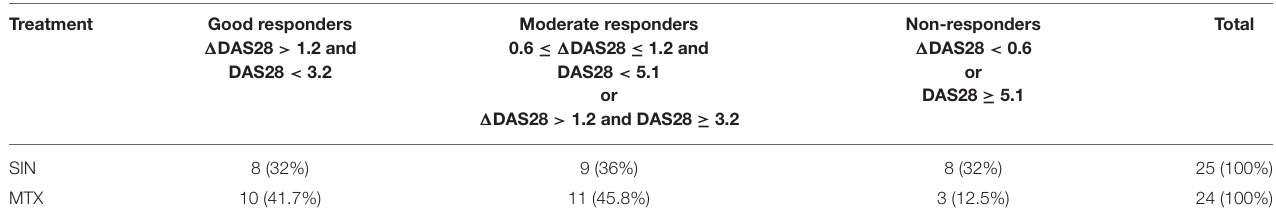
TABLE 3 | Numbers of patients responding to different treatment